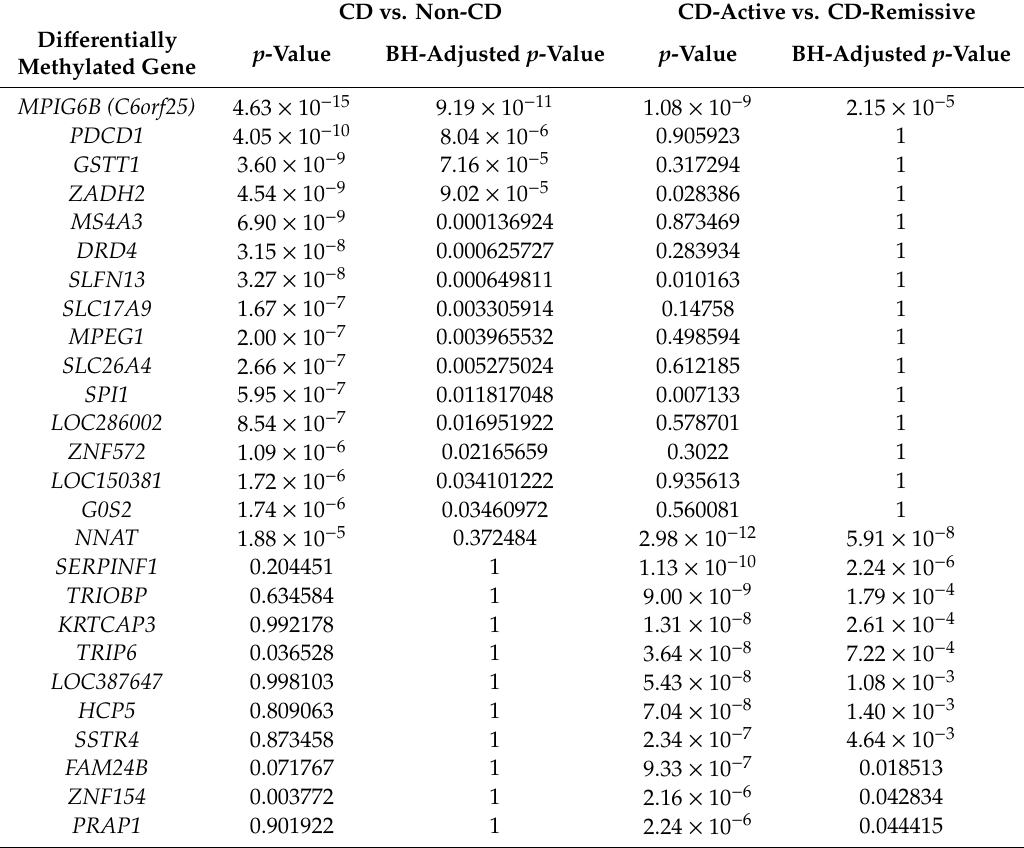
Table 2. Overview of all the DMGs found in this study alongside the relevant statistics. In short, p -values were obtained using Brown’s method and adjusted for multiple testing using the Benjamini–Hochberg method against all